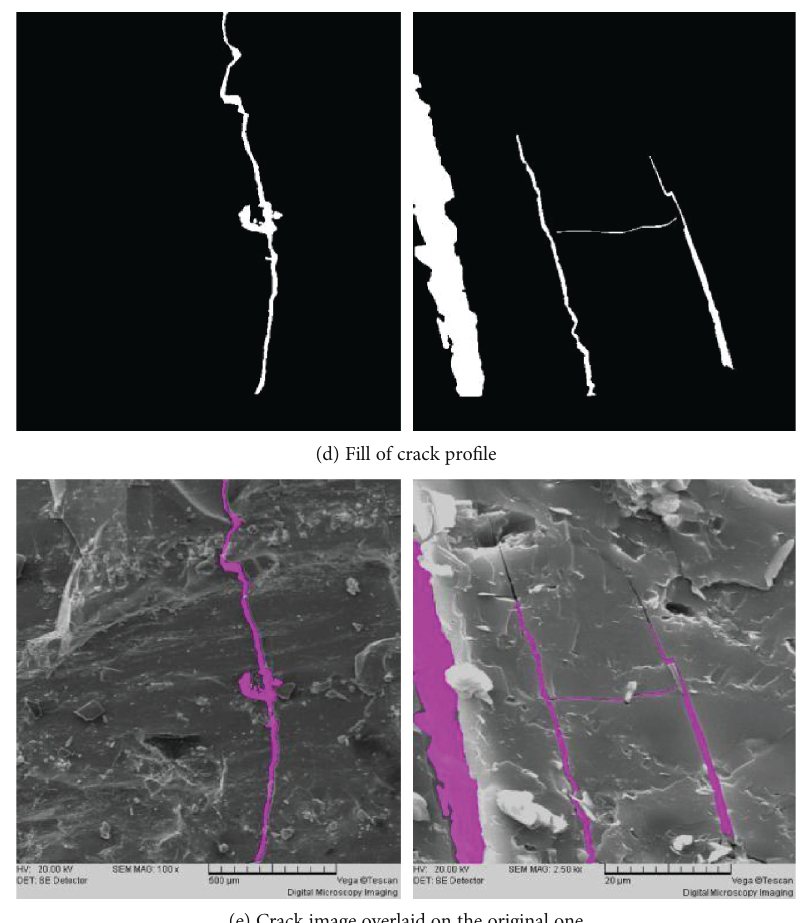
Figure 4: Extraction of crack information.